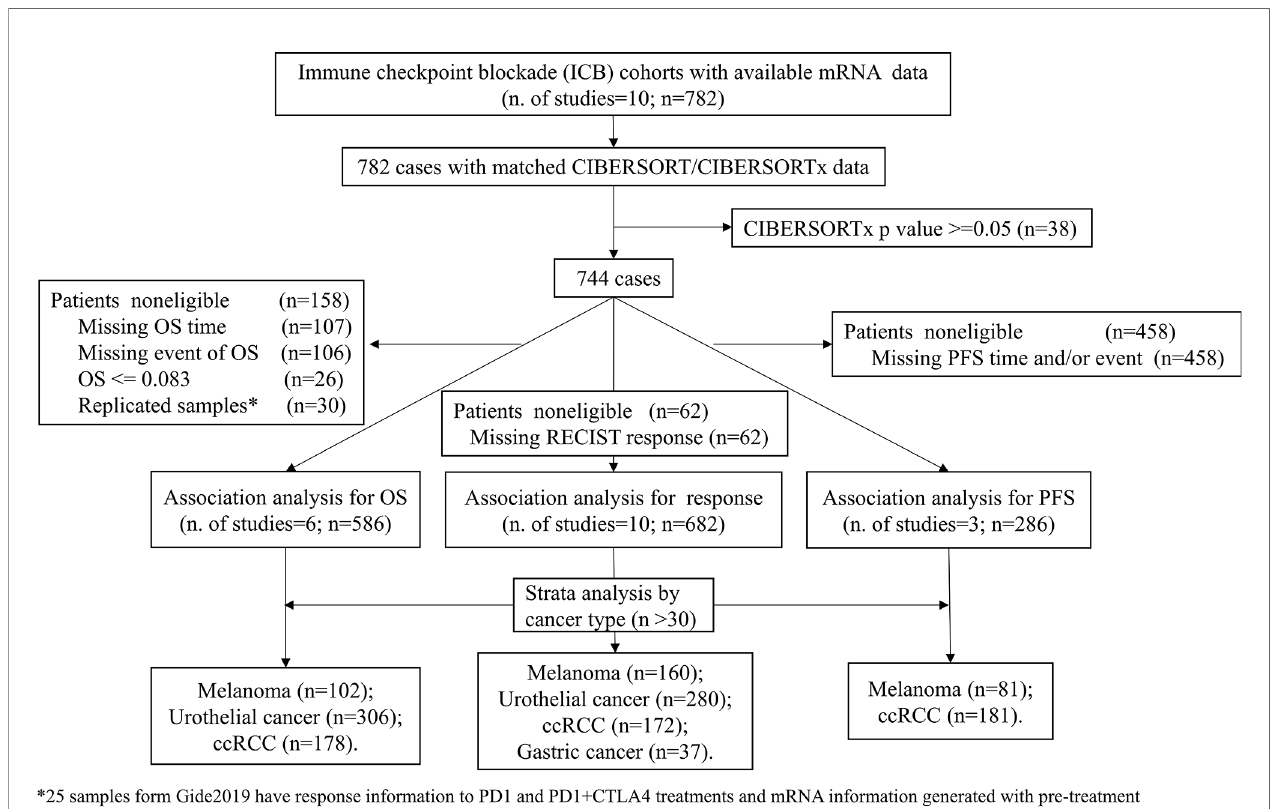
FIGURE 1 | Study fl ow diagram. OS, Overall survival; PFS, Progression-free survival, ccRCC, clear cell renal cell